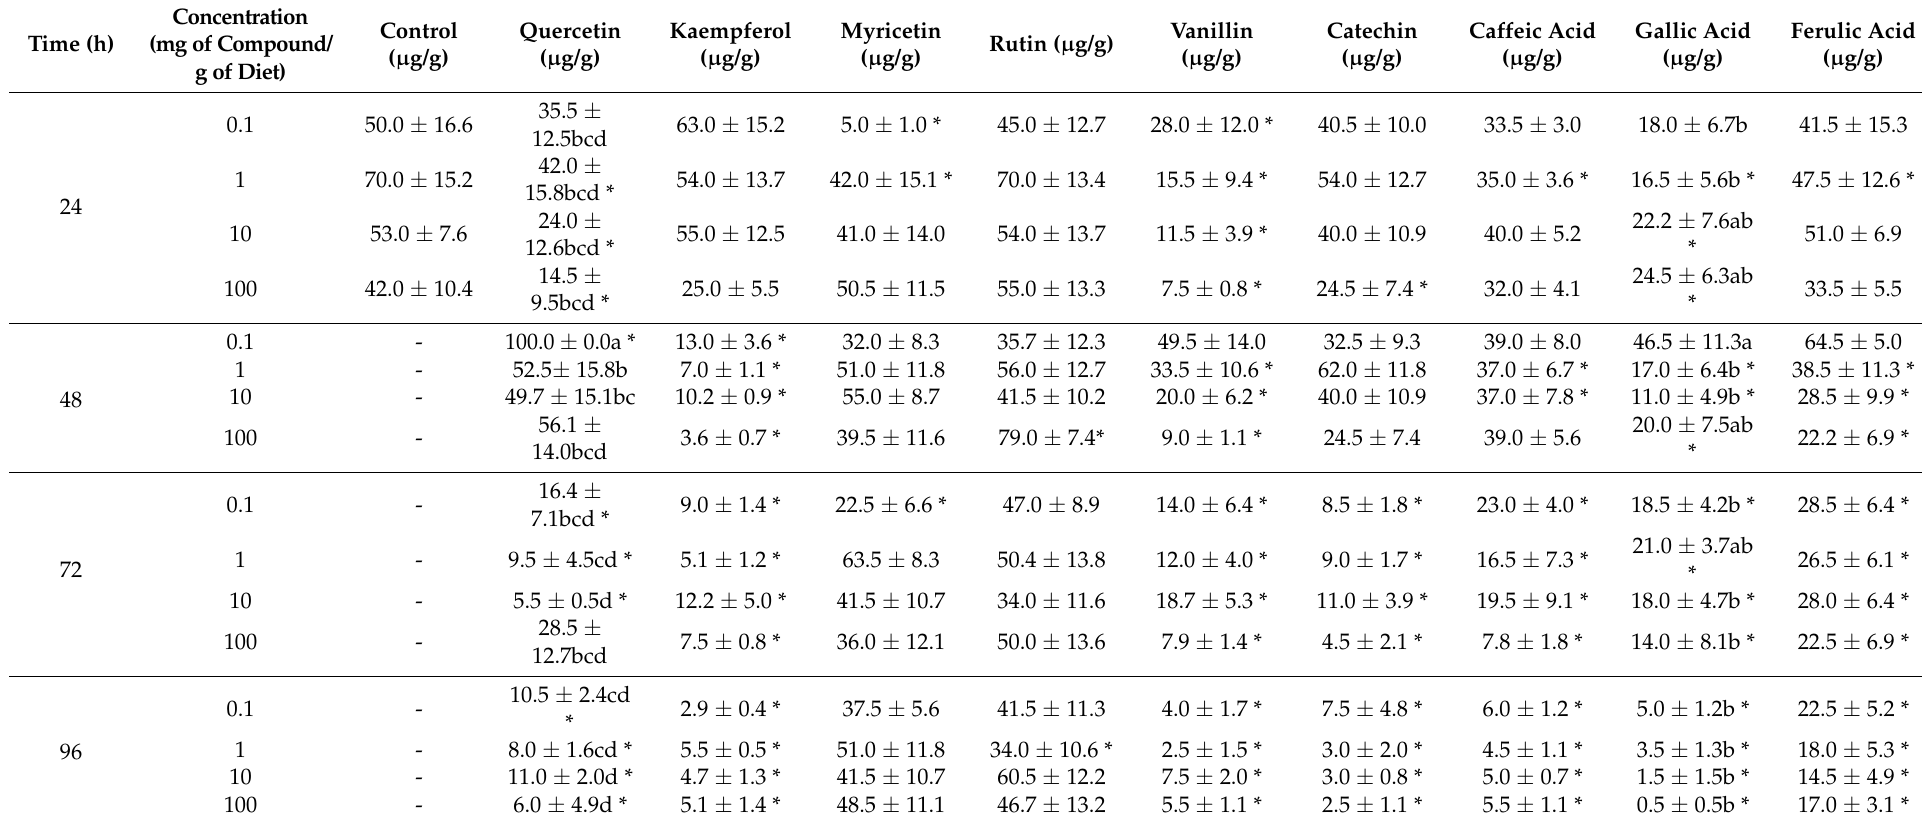
Table 3. Percentage of diet consumption by C. rudis at several doses and different times (h). Letters indicate significant differences according to ANOVA followed by Tukey’s test. ANOVA was performed for each individual compound in relation to dose and time. * Significant differences in relation to control treatment according to Student’s t -test for respective time (h) and